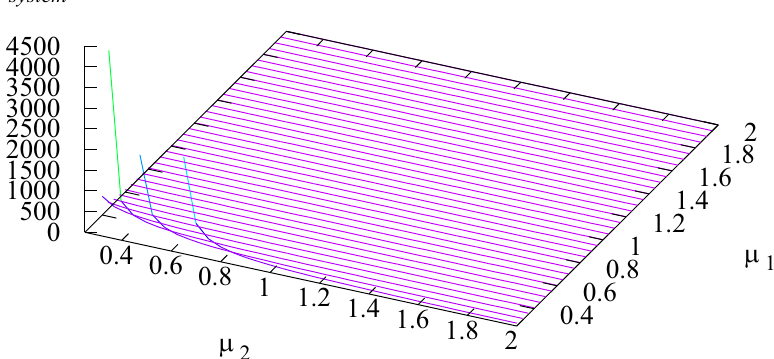
Figure 13. Dependence of the average number of customers in the system L system on the parameters µ 1 and µ 2 .